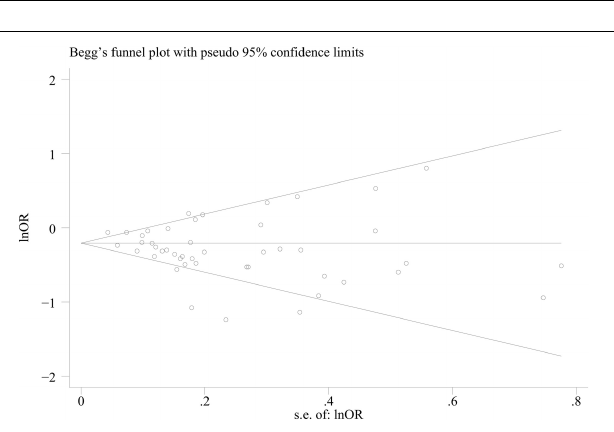
FIGURE 3 | Dose-response association between tea drinking and risk of cognitive disorders.